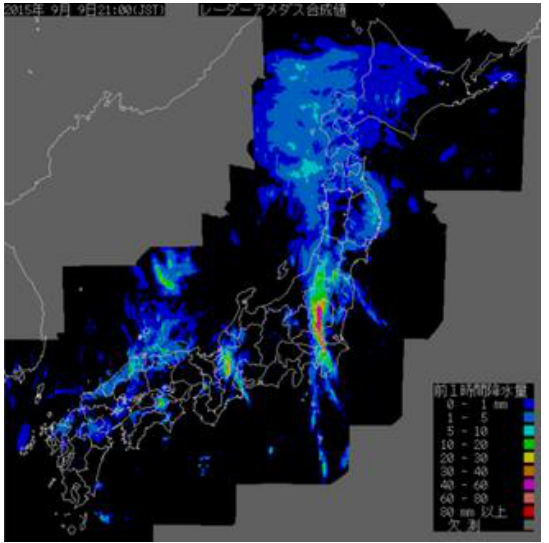
Figure 2. One-hour rainfall distribution map on 21:00, Sept. 9, 2015. A strip of heavy rainfall can be observed along the Kinugawa river catchment (CEReS,